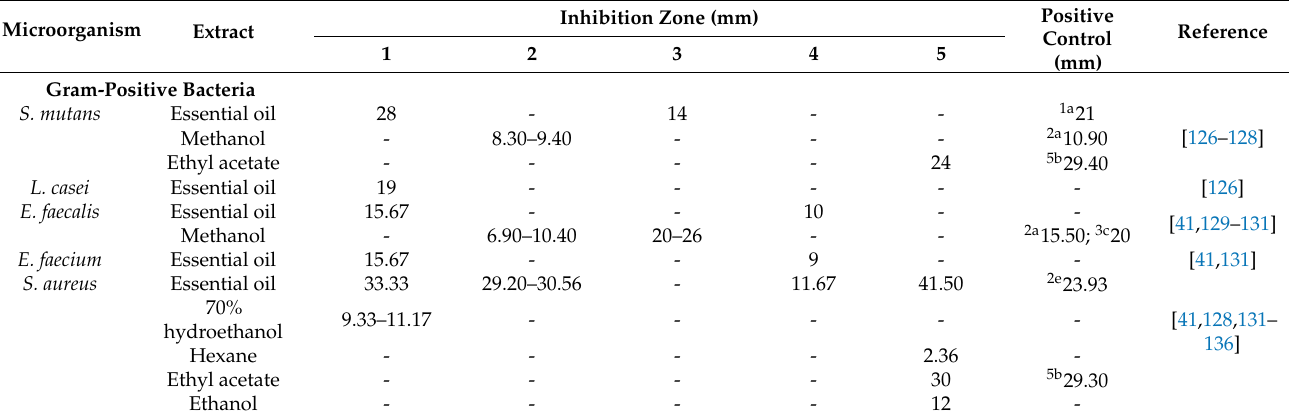
Table 6. Data of inhibition zone of Ocimum